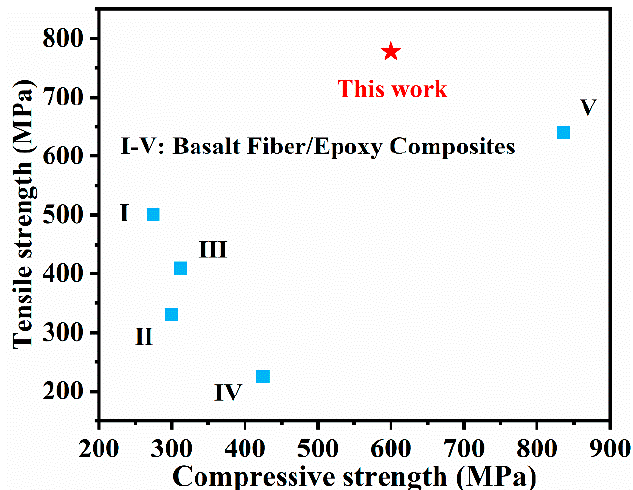
Figure 6. Comparison of tensile and compressive strength of BF-PEN/PPENK with BF/EP composites (I–V: